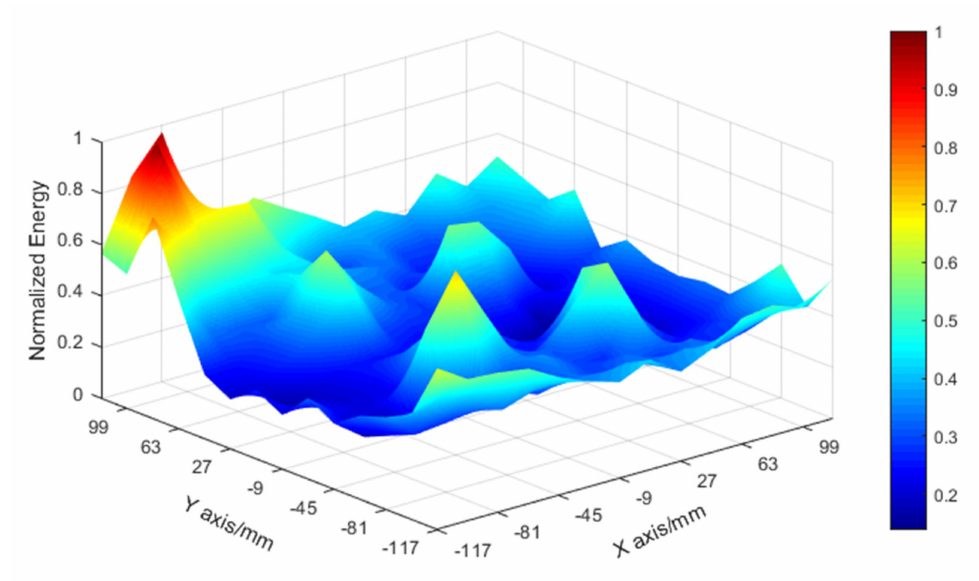
Figure 6. Normalized energy contour map of a sandwich panel sensed by FBG1.